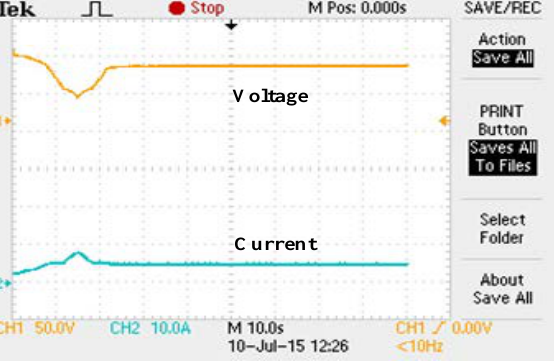
Figure 17. PV output power for the scenario of Figure 16.